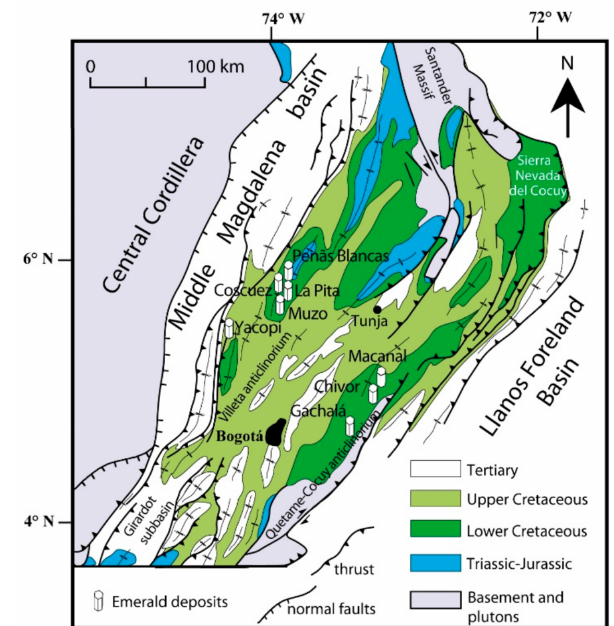
Figure 23. Simplified geological map of the basin from the Eastern Colombian Cordillera. The emerald deposits are hosted by Lower Cretaceous sedimentary rocks forming two mineralized zones located, respectively, on the eastern and western borders of the basin. On the western border, with the mining districts of La Glorieta-Yacopi, Muzo, Coscuez, La Pita, Cunas, and Peñas Blancas, and on the eastern border are Gachal á , Chivor, and Macanal.